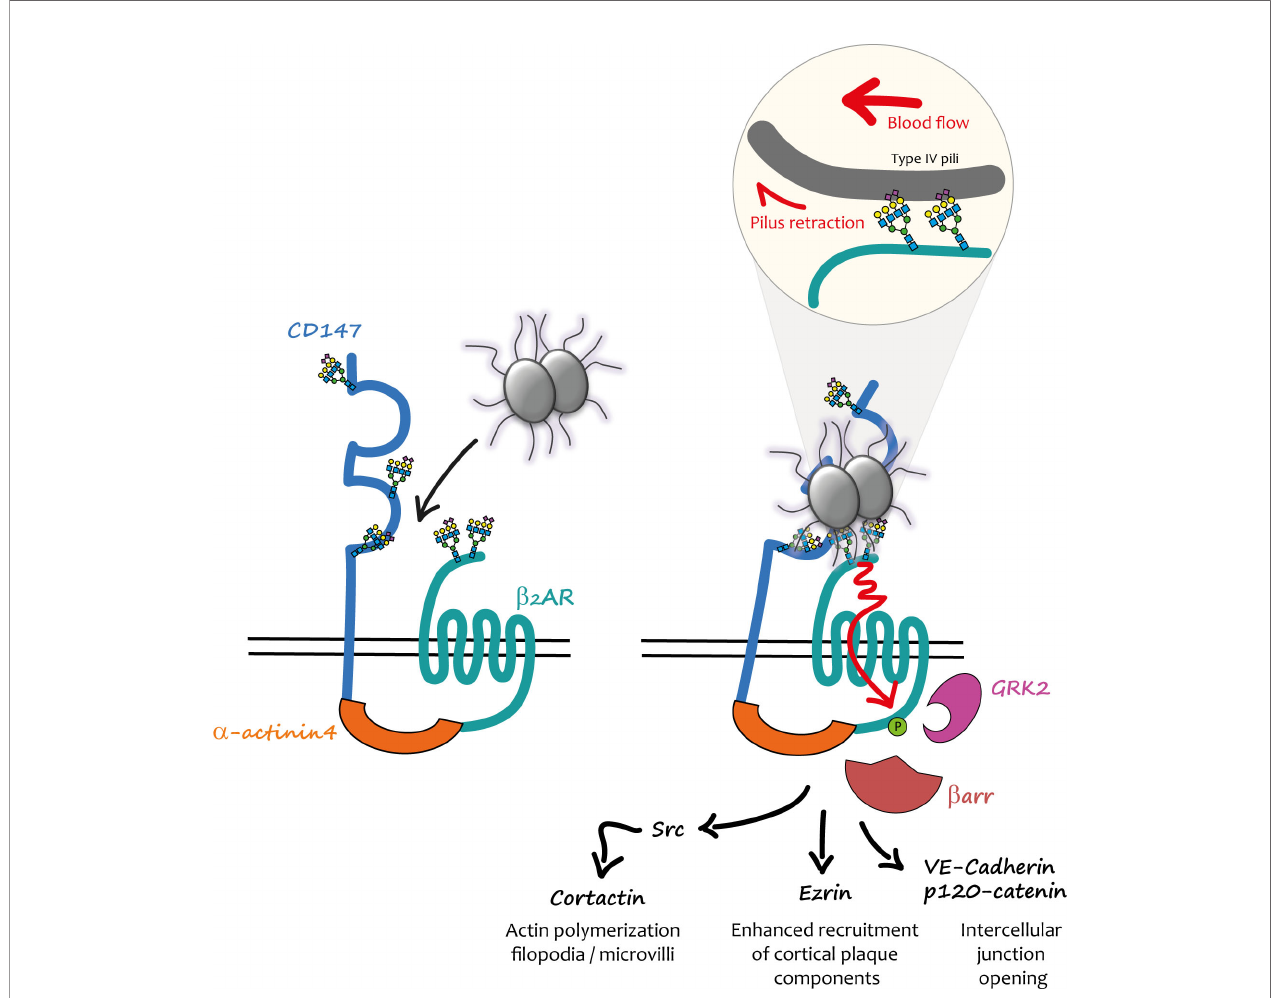
FIGURE 1 | Mechanical activation of the CD147- b 2 AR heterodimer by meningococcus in endothelial cells. (Left) In endothelial cells CD147 and b 2 AR are pre-assembled into heterodimers stabilized by a -actinin4; the physiological role of these complexes is still unknown. When meningococci penetrate into the blood stream, they interact with these heterodimers via the PilE and PilV pilins of their TFP. (Right) The fi rst interaction presumably involves CD147 and is accountable for its “ early adhesion ” . Terminal Neu5Ac (sialic acid) of the N-glycan chains present in the proximal IgG domain of CD147 constitutes the binding site of TFP pilins. Other TFP interact via PilE and PilV with the terminal Neu5Ac of close b 2 AR N-glycan chains. TFP retraction powered by PilT and forces generated by the blood fl ow concur to the mechanical activation of the b 2 AR (enlarged inset). The conformational change induced by this activation produces a cascade of signalling events promoted by b arr translocation to GRK2-phosphorylated b 2 AR. Once the “ stable adhesion ” of bacterial colonies is achieved meningococci cross the endothelium through intercellular